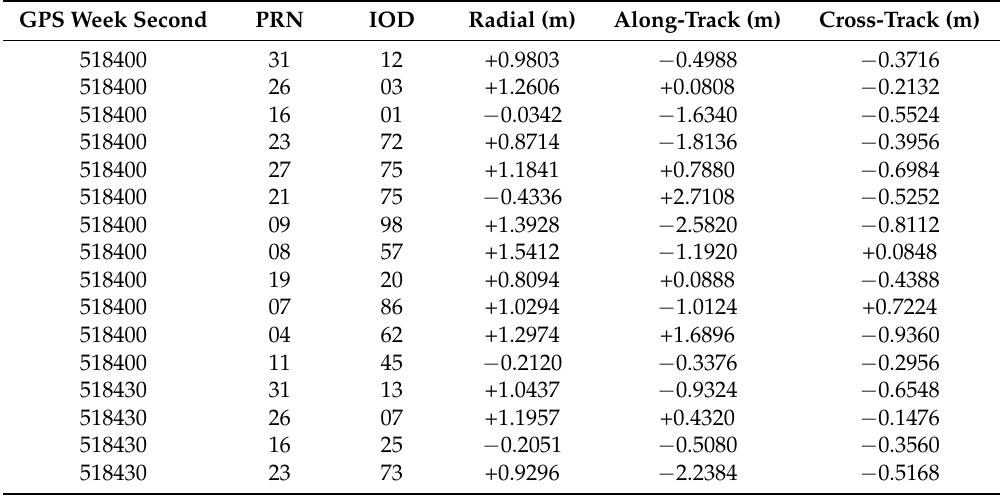
Table A1. Sample satellite orbit corrections provided by SSR